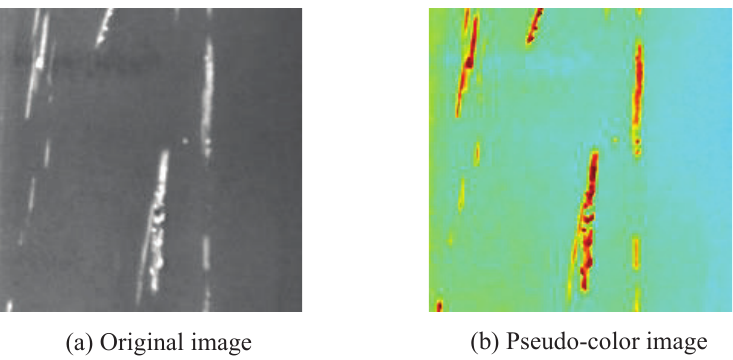
Figure 6. Pseudo-color enhancement effect. ( a ) original image, ( b ) pseudo-color image.